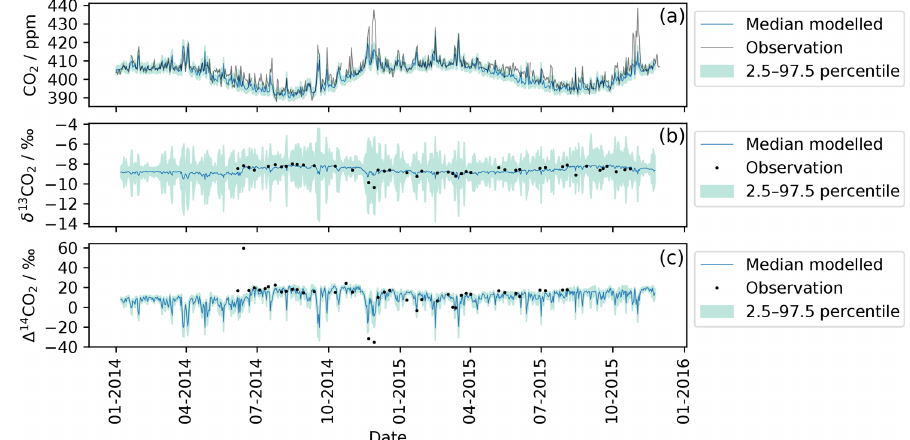
Figure 2. Comparison of modelled and observed CO 2 for each isotope at TAC. The black line and dots represent observations measured at the TAC field station. The blue line corresponds to the median modelled value (according to Sect. 3.2). The shaded green area represents the uncertainty estimate for the modelled values based on the bootstrapping method described in Sect. 4.1. Panel (a) compares observed and modelled 12 CO 2 values. Panel (b) contains both modelled 13 CO 2 and flask-sampling-based observations, while (c) shows the modelled and observed 14 CO 2